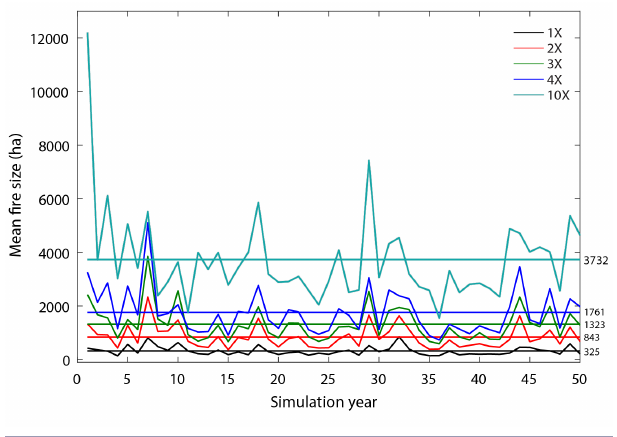
Fig. 4 . Mean fire size by year of simulation for 15 replicate runs for each wildfire scenario (1X, 2X, 3X, 4X, 10X, and see Table 2 for total area burned per year in each scenario). Increased levels of wildfire activity in each scenario were achieved by multiplying the burn period of each ignition over contemporary levels by the multiplier indicated.